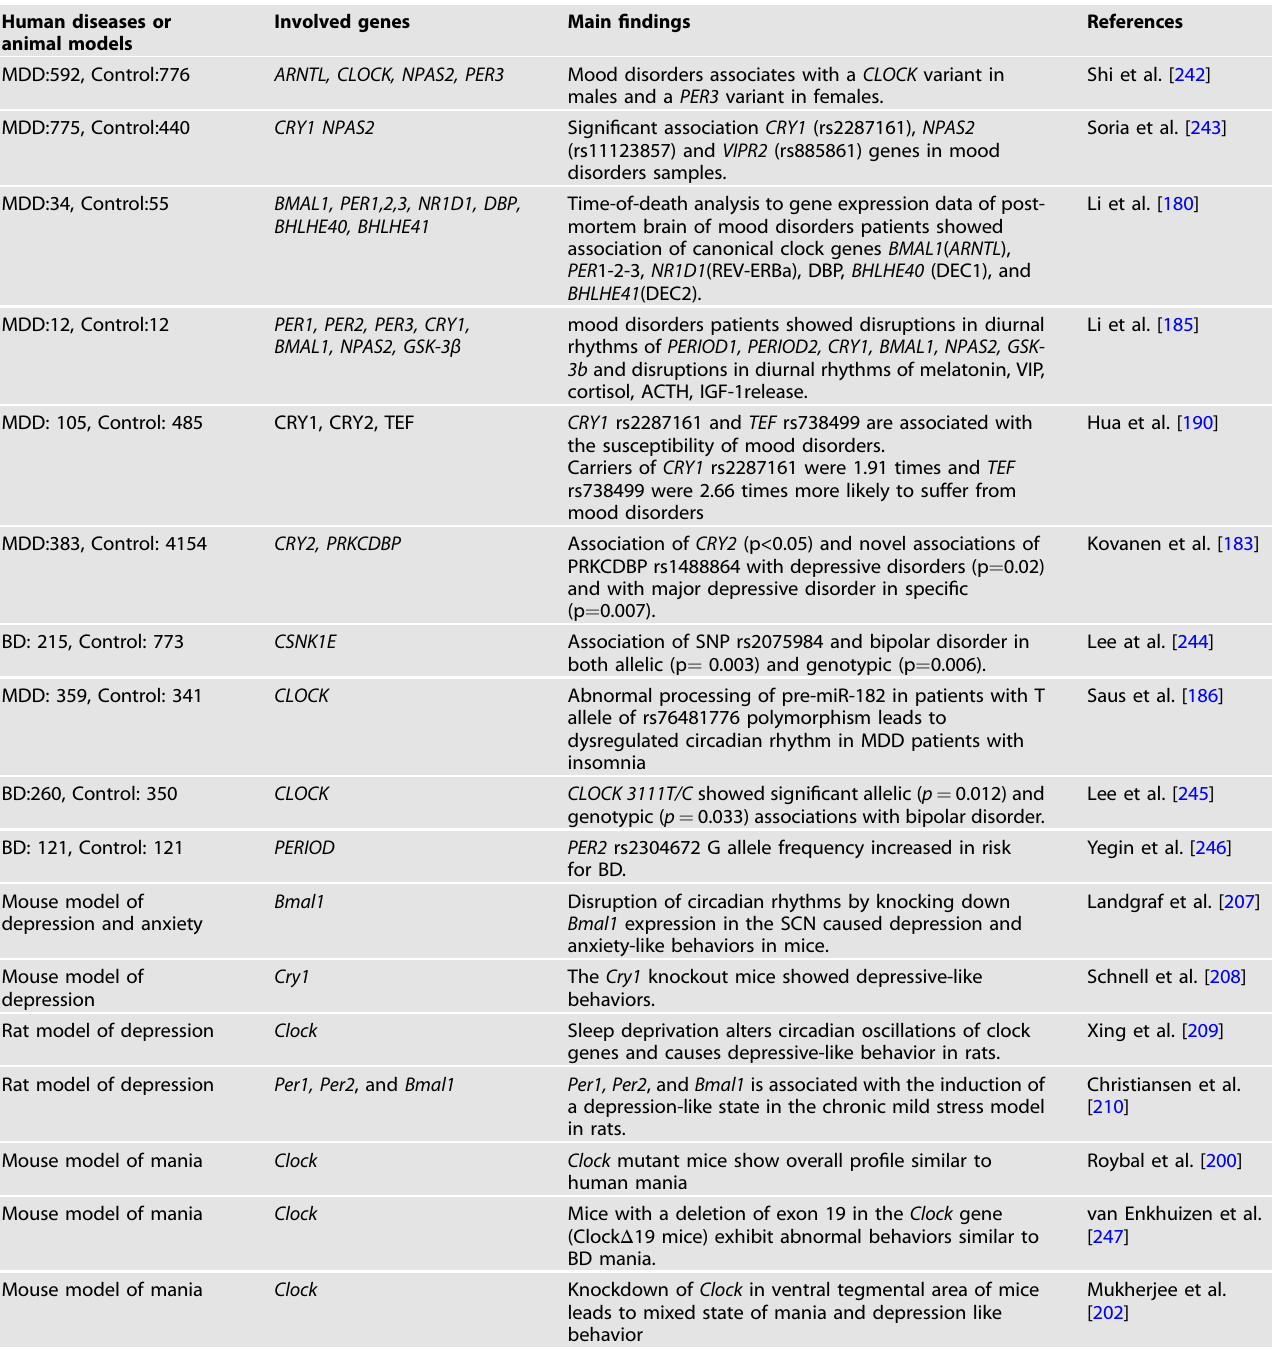
Table 1. Disruption of clock genes in mood